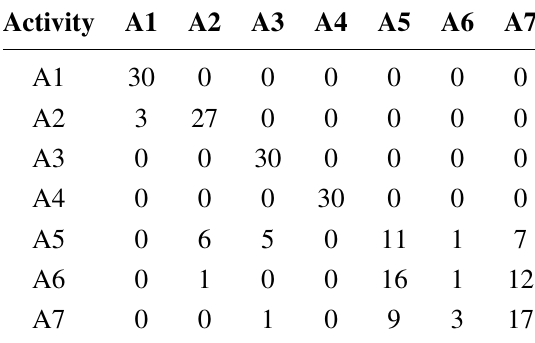
Table 4. Confusion matrix for Hockey Smartphone data using Experiment